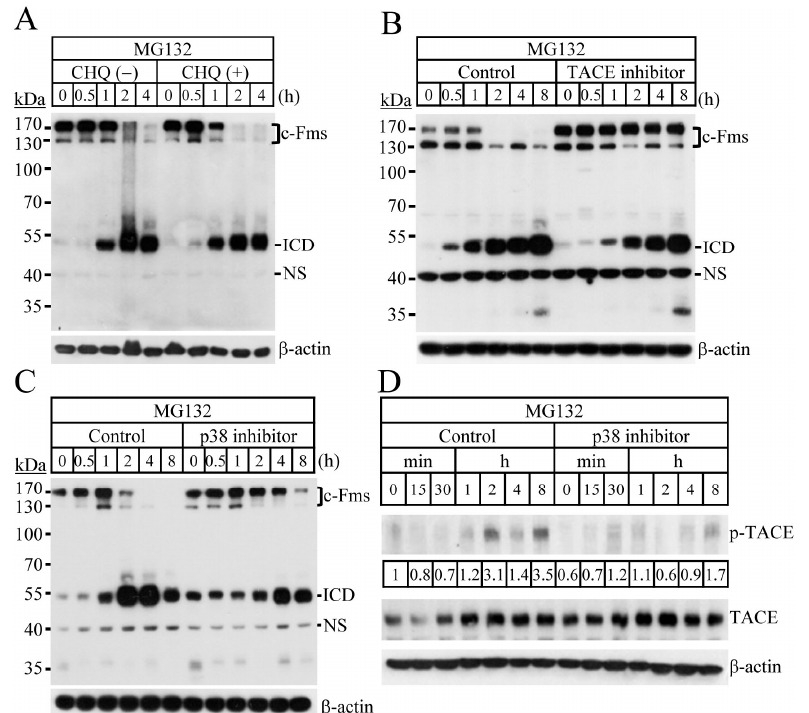
Figure 3. c-Fms is degraded through RIPping induced by p38-mediated tumour necrosis factor-alpha converting enzyme (TACE) activation. Osteoclast progenitors were treated with MG132 (10 µ M) in the presence or absence of chloroquine (CHQ, 2 µ M, ( A )), and TAPI-0 (100 µ M, ( B )); ( C , D ) osteoclast progenitors were starved of M-CSF, incubated with 20 µ M SB203580 (a specific inhibitor of p38) for 30 min, and then treated with MG132 (10 µ M). Fold changes of phosphorylated-TACE (p-TACE) were presented. ICD, intracellular domain of c-Fms; NS, nonspecific bands.